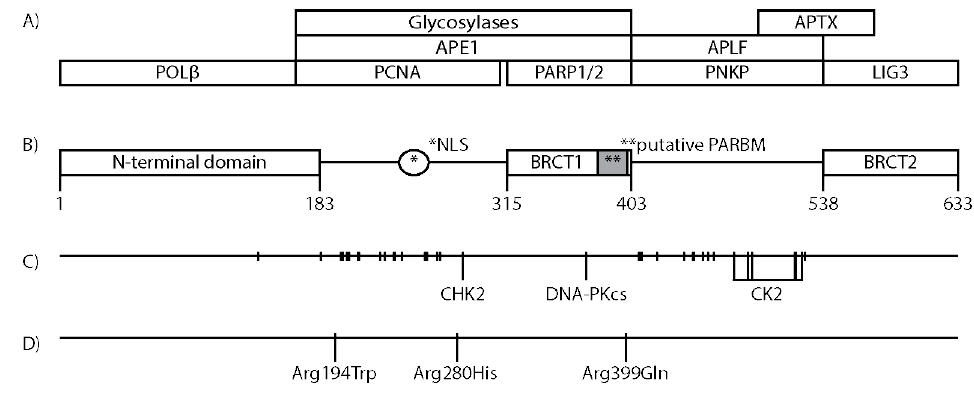
Figure 2. XRCC1 map. ( A ) Approximate XRCC1 protein interacting regions; ( B ) XRCC1 domains; ( C ) Known XRCC1 Ser/Thr phosphorylations and XRCC1 interacting kinases (Chk2: Thr284, DNA-PKcs: Ser371, CK2: cluster of six residues from Ser475 to Ser523, possibly more); ( D ) The three most prevalent XRCC1